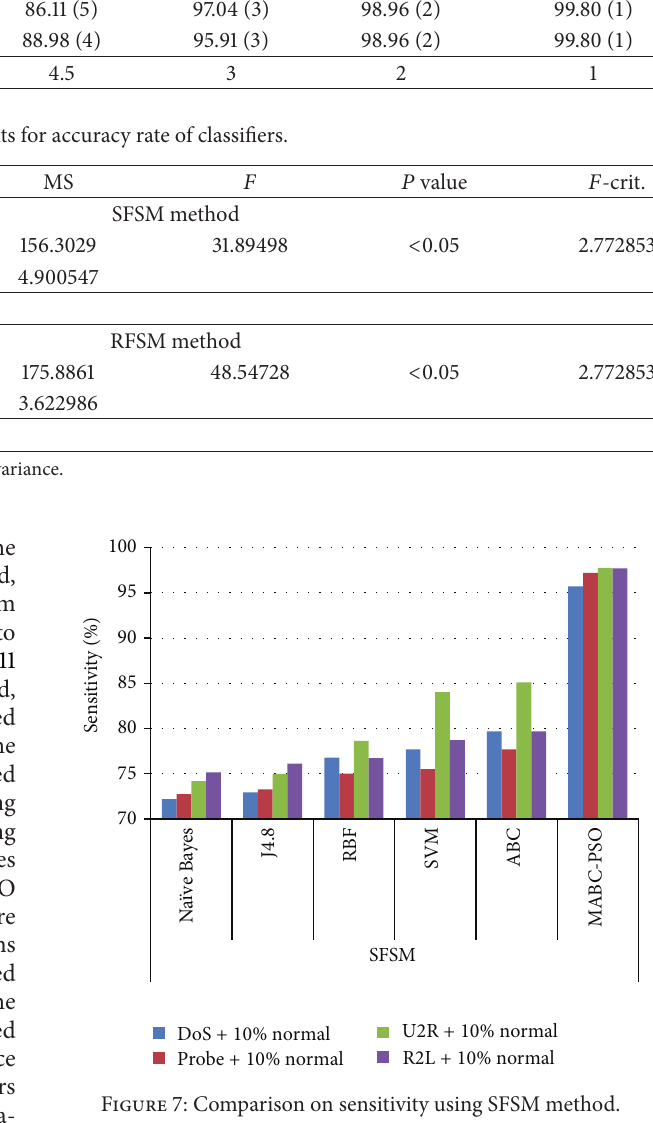
when the proposed MABC-EPSO with random feature selec- tion method is employed. MABC-EPSO with SFSM also shows a comparable performance than other classifier combi- nations. The performance of NB, j4.8, and RBF is better in terms of specificity and sensitivity using RFSM method com- pared to SFSM